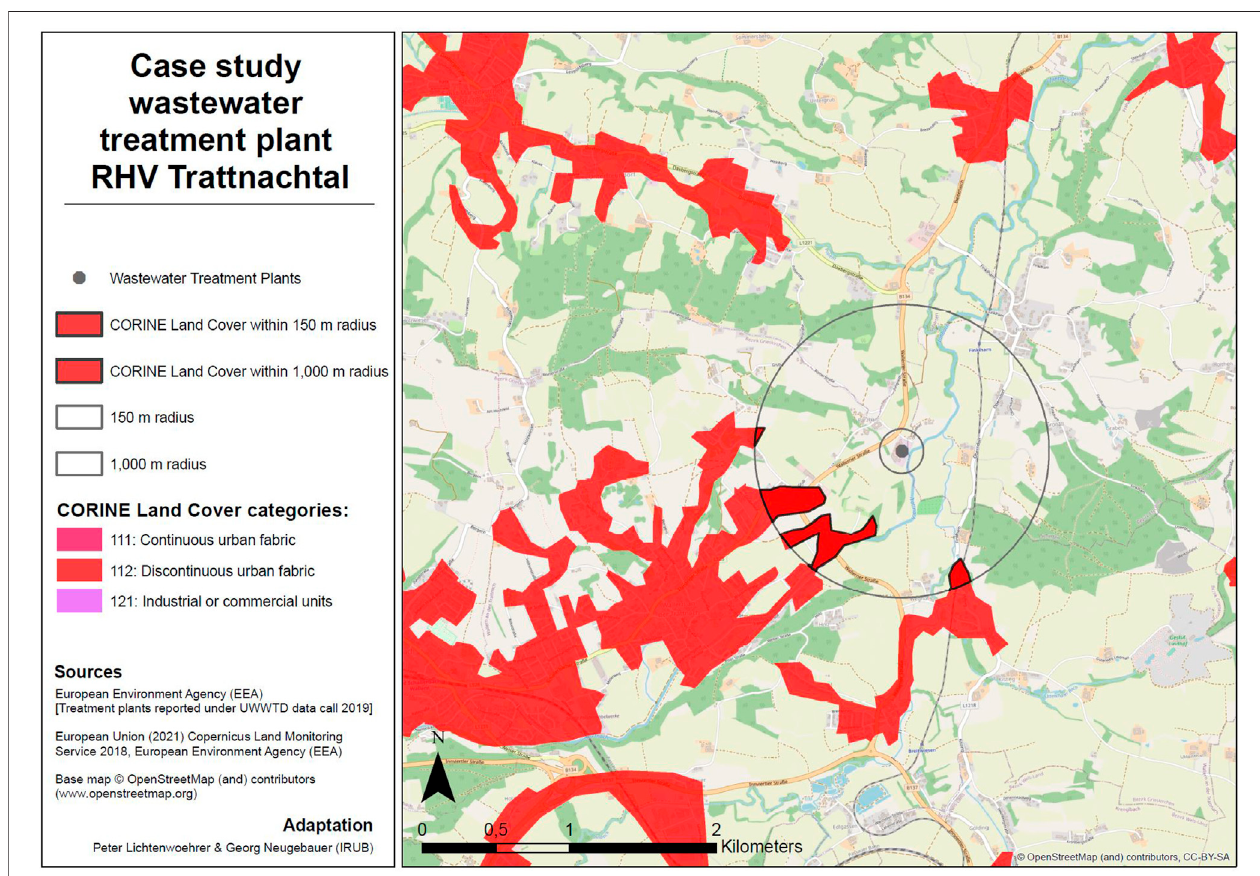
FIGURE 4 | Location of the case study WWTP including its spatial context (own illustration).